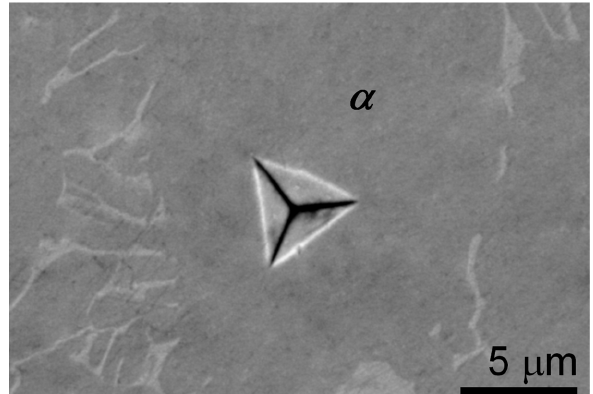
Figure 12. FESEM magnification micrograph of a specific location of a residual imprint performed at 700 nm of maximum displacement into the surface, where individual imprints within the Ti-6Al-4V α -phase are clearly appreciated (white dashed square presented in Figure 9).